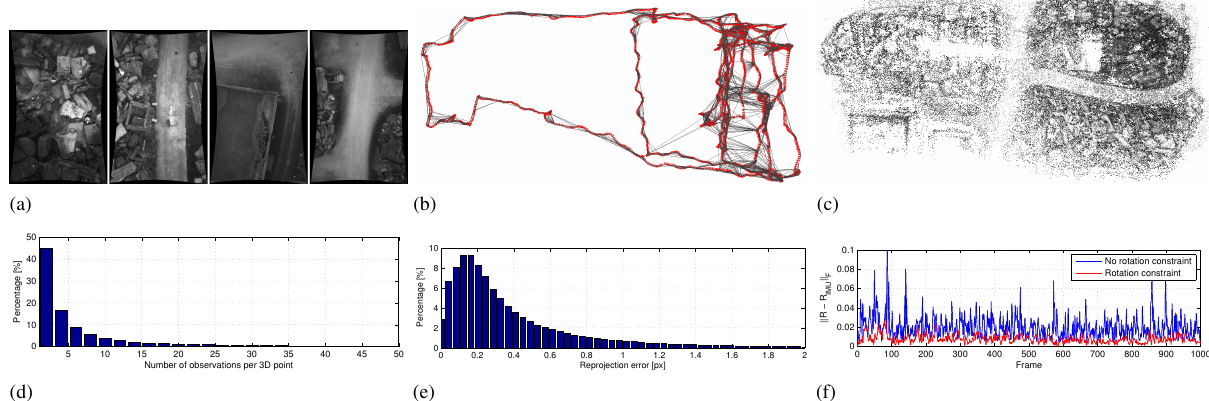
Figure 2: Rubble 1 data-set: Low-resolution, undistorted MAV image sequence (a), reconstructed trajectory with loop-closure connec- tions (b), resulting sparse 3D point cloud (c), clipped track-length histogram with maximum track-lengths up to 567 (d), the reprojection error histogram (e), and the deviation of rotation estimates from IMU orientation ( λ r = 10 ) for one of the sub-sequences (f).